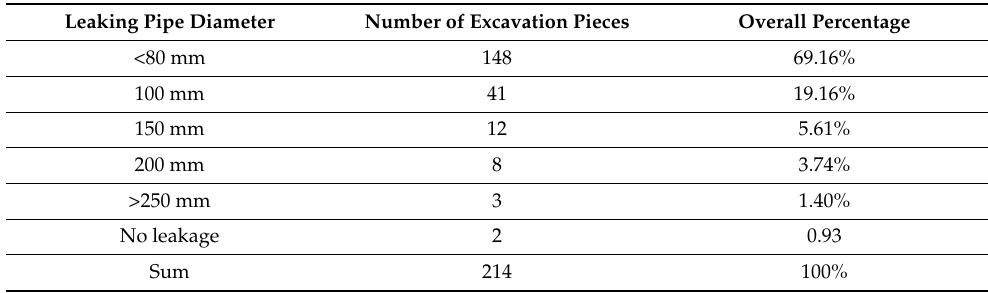
Table 2. Localized AI water leakage diagnostic instrument excavation verification: leaking pipe diameter